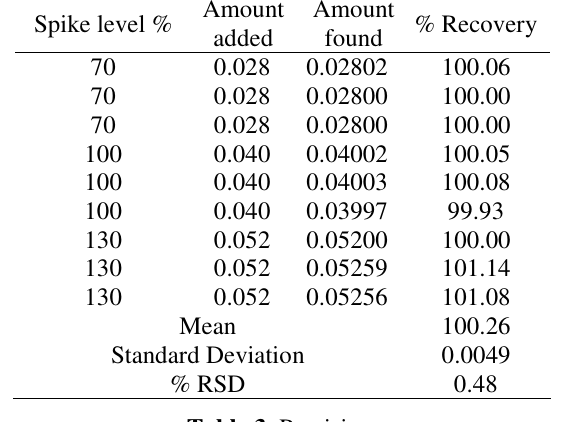
Table 3 . Precision.